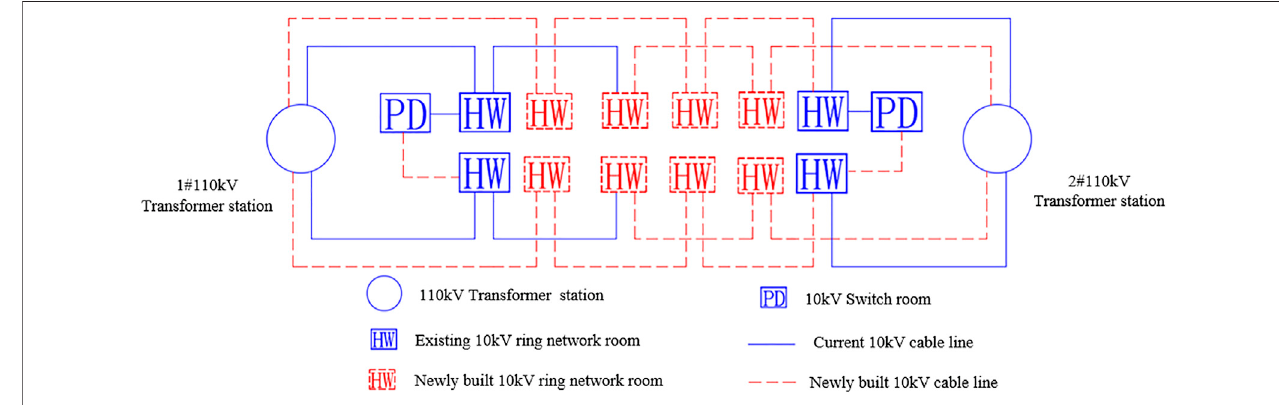
FIGURE 8 | The fi rst wiring mode modi fi cation plan.